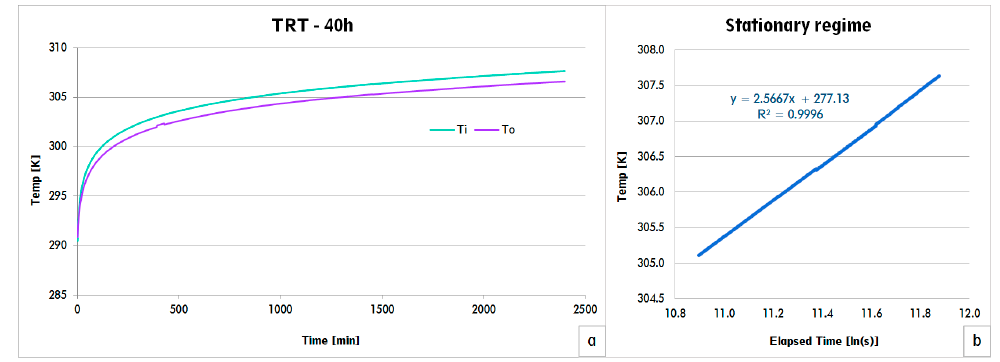
Figure 6. ( a ) TRT results for the time lapse of 40 h, ( b ) stationary regime considering 1500 sampling values.